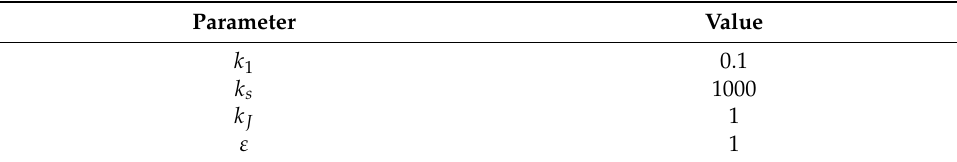
Table 4. Control gains for nonlinear controller.